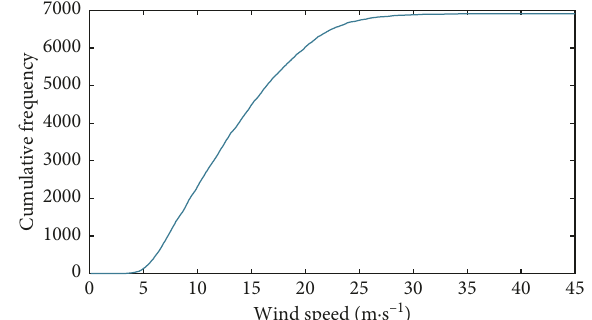
Figure 2: Example of cumulative frequency results for the daily maximum instantaneous wind speed data from the Heuksando ASOS